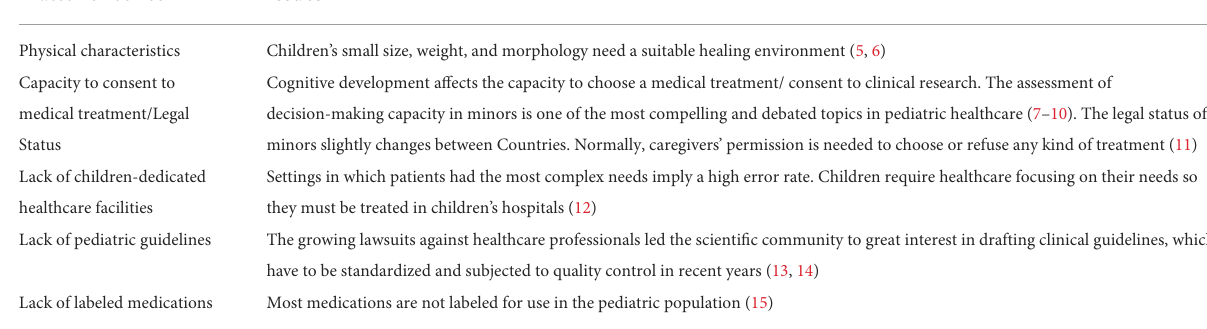
TABLE 1 Major concerns regarding pediatric patient